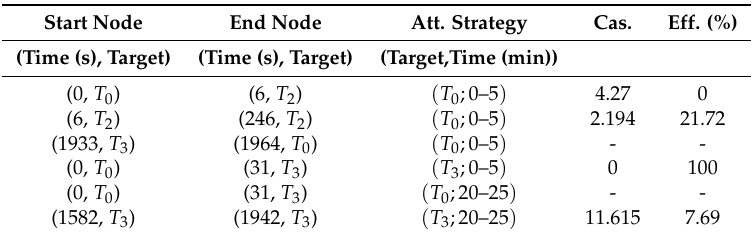
Table 3. Illustrative example of agent-based outcomes. Cas. denotes the average number of casualties. Eff. represents the efficiency of the patrol for each movement, which is defined as the percentage of simulation runs in which the defender successfully arrested the